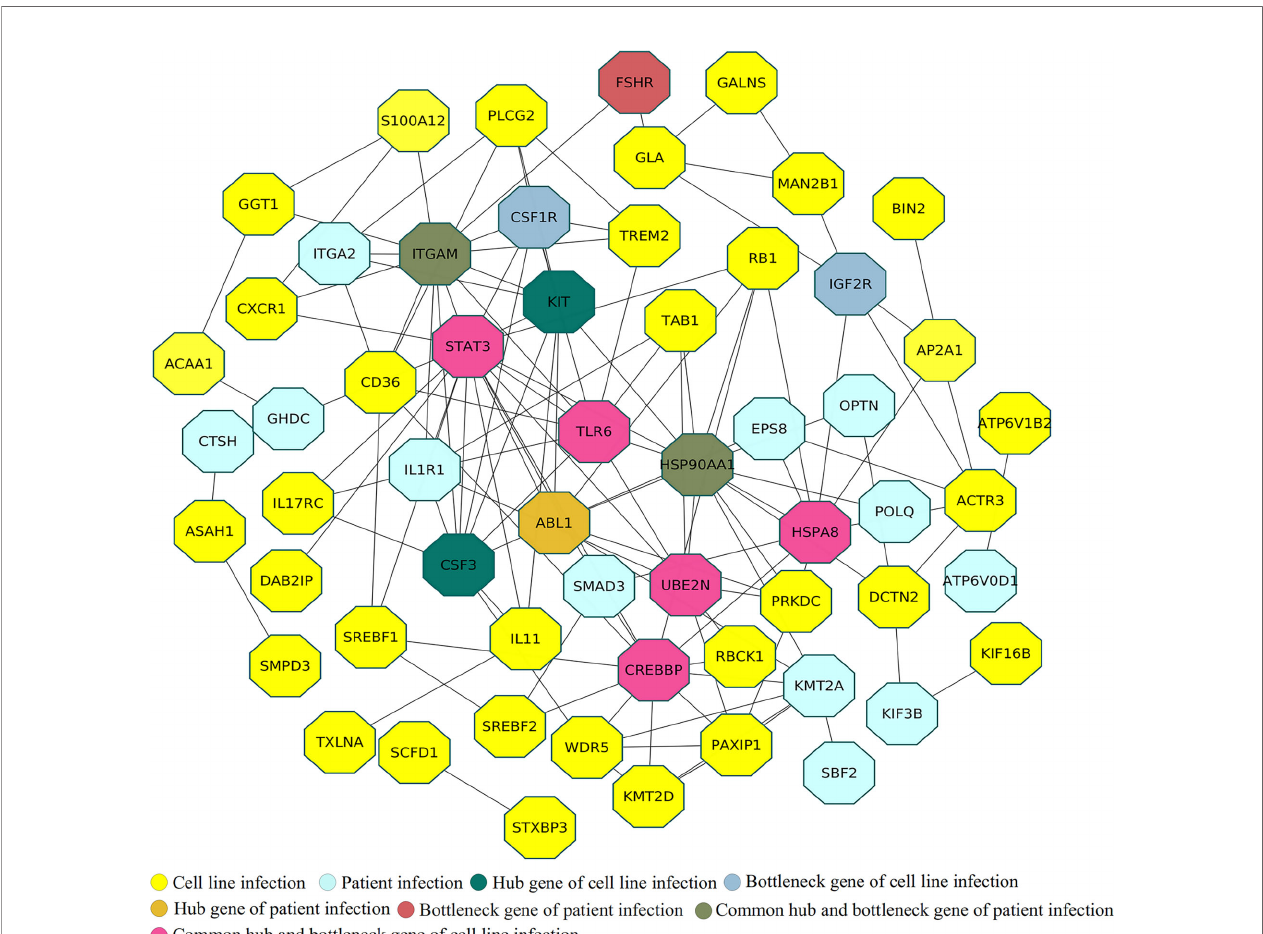
FIGURE 3 | Protein interaction analysis among uniquely identi fi ed immune system genes in cell-line and patient proteomes.